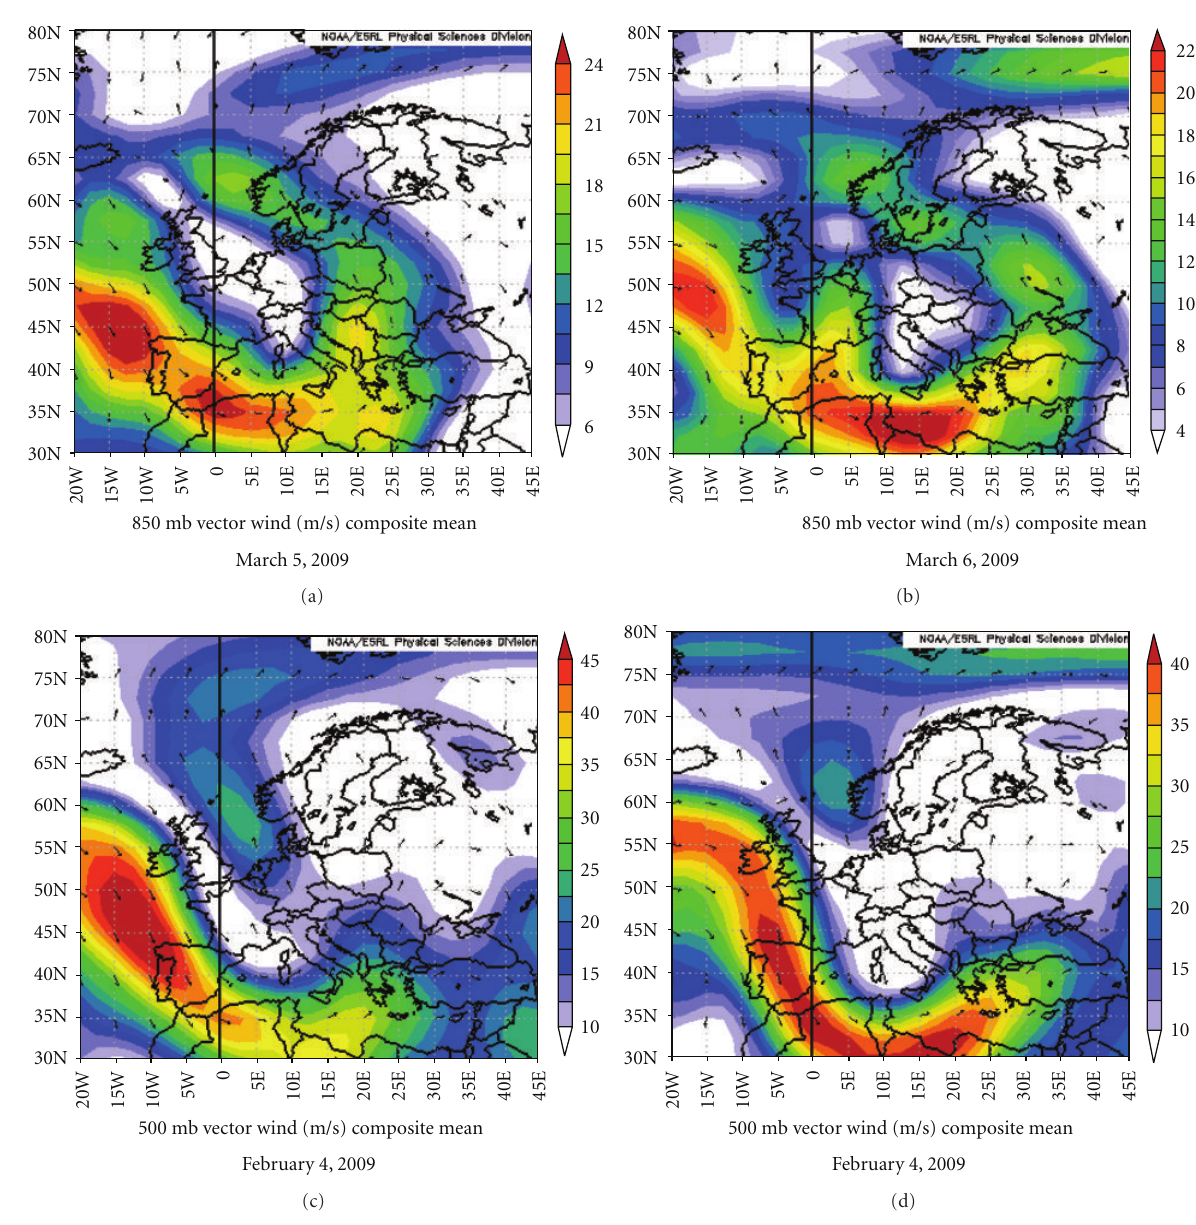
Figure 13: Spatial distribution of vector wind composite mean (m/s) at 850hPa level ((a) and (b)) and 500 hPa ((c) and (d)), during the Saharan episodes on March 5, 2009 ((a) and (c)) and March 6, 2009 ((b) and (d)), using NCEP/NCAR reanalysis